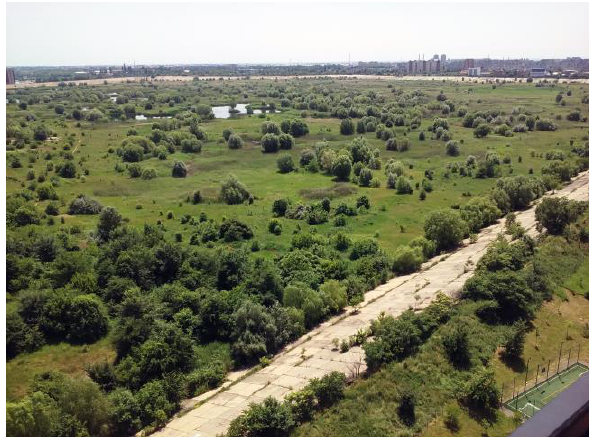
Figure 9. Văcărești nature park, Bucharest,